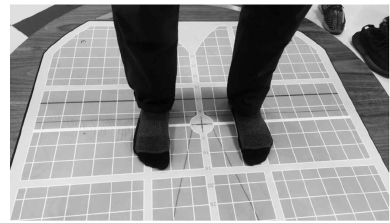
Figure 2. Individuals stood on a posturography force platform with both feet in the standard posi- tion.